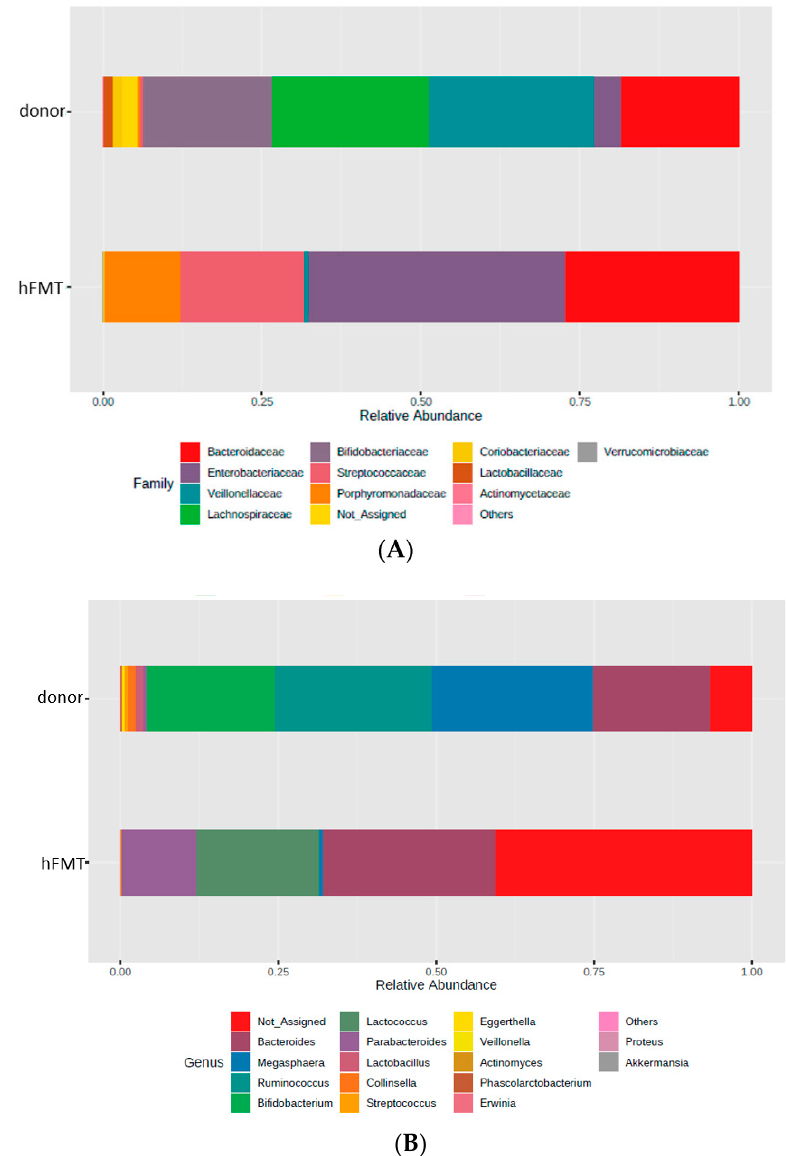
Figure 4. Relative abundances of bacterial taxa (family and genus) in donor feces and feces of mice subject to hFMT. The panel ( A ) shows the relative abundance of bacteria at family level of the donor sample while panel ( B ) shows the same at genus level.